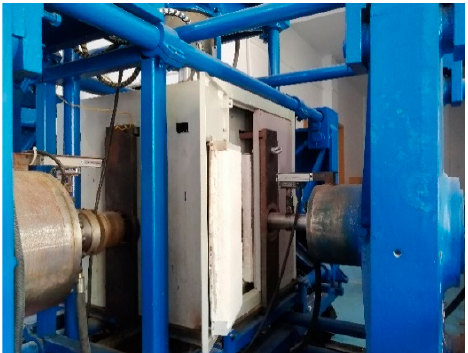
Figure 3. High-temperature true triaxial loading test system.